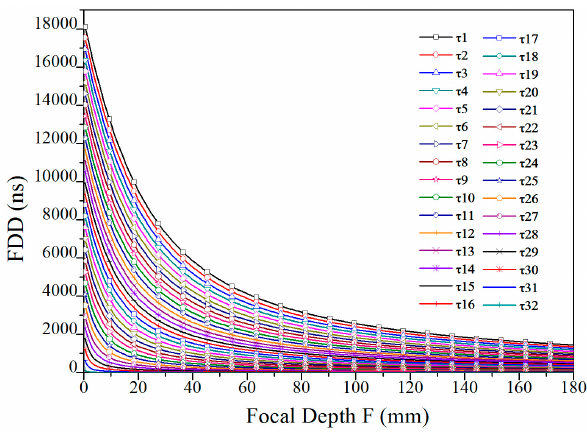
Figure 6. Focusing delay data τ j ( F , β j ) of each channel.